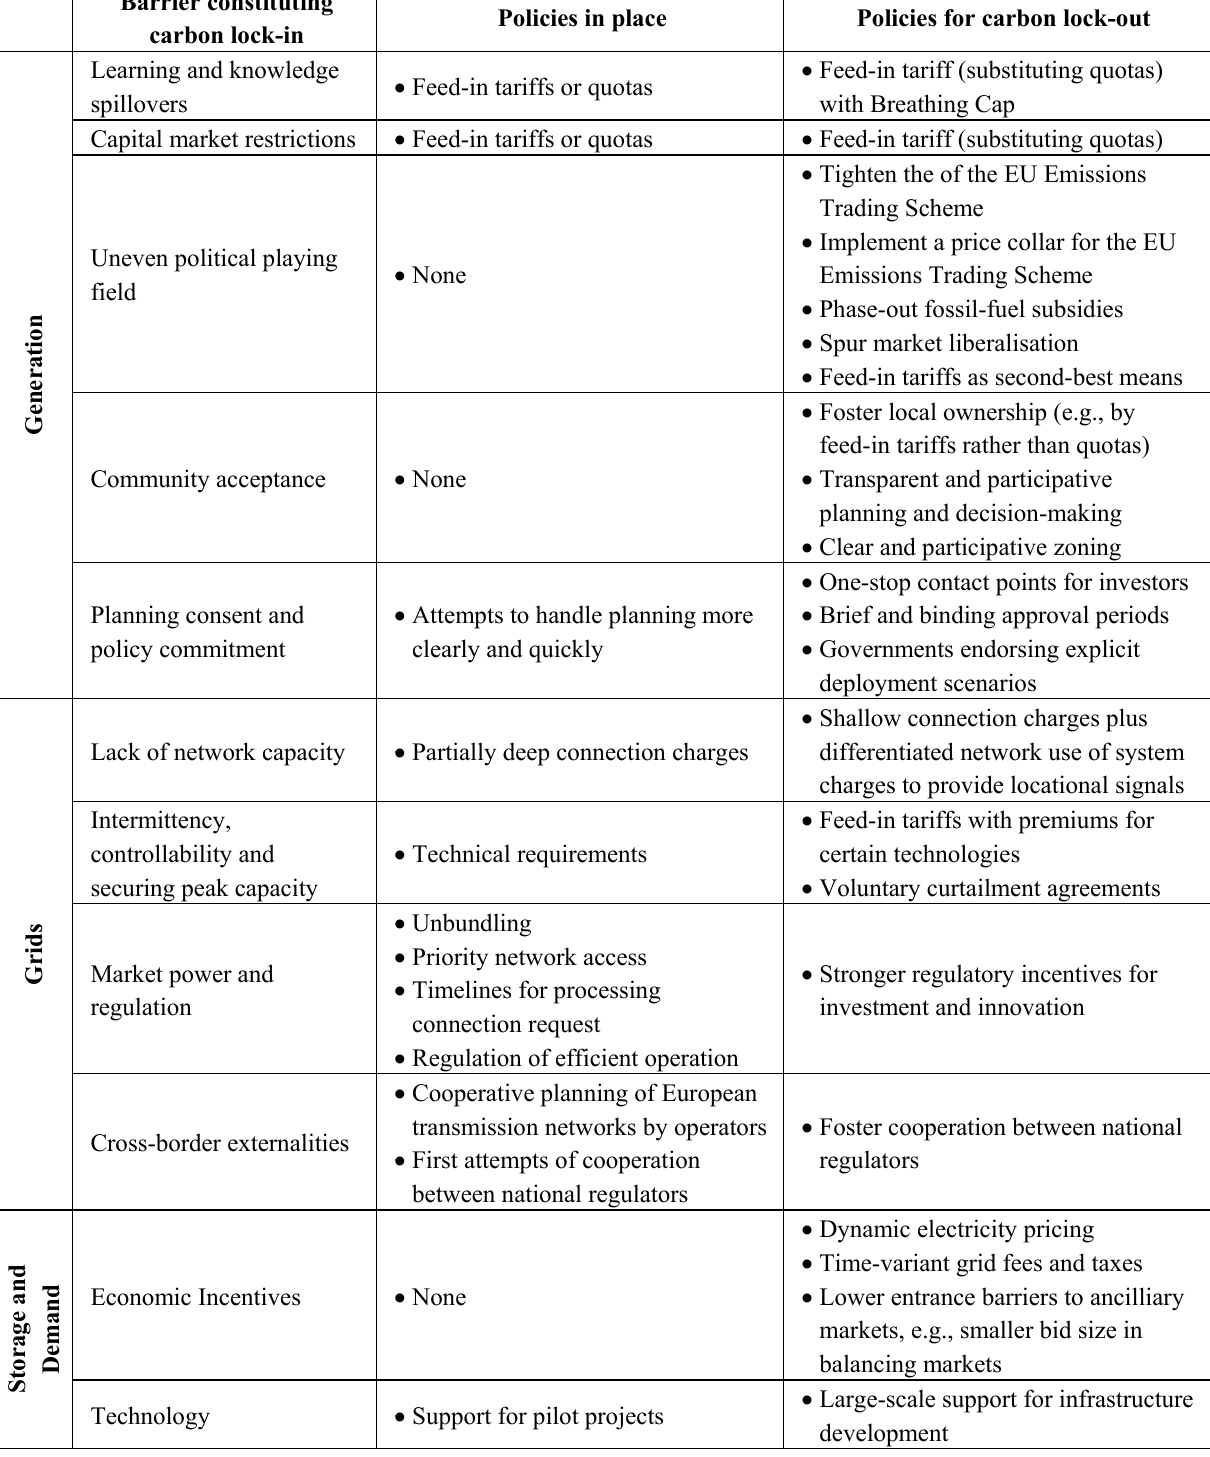
Table 1. Specific barriers constituting a carbon lock-in and corresponding policies. Barrier